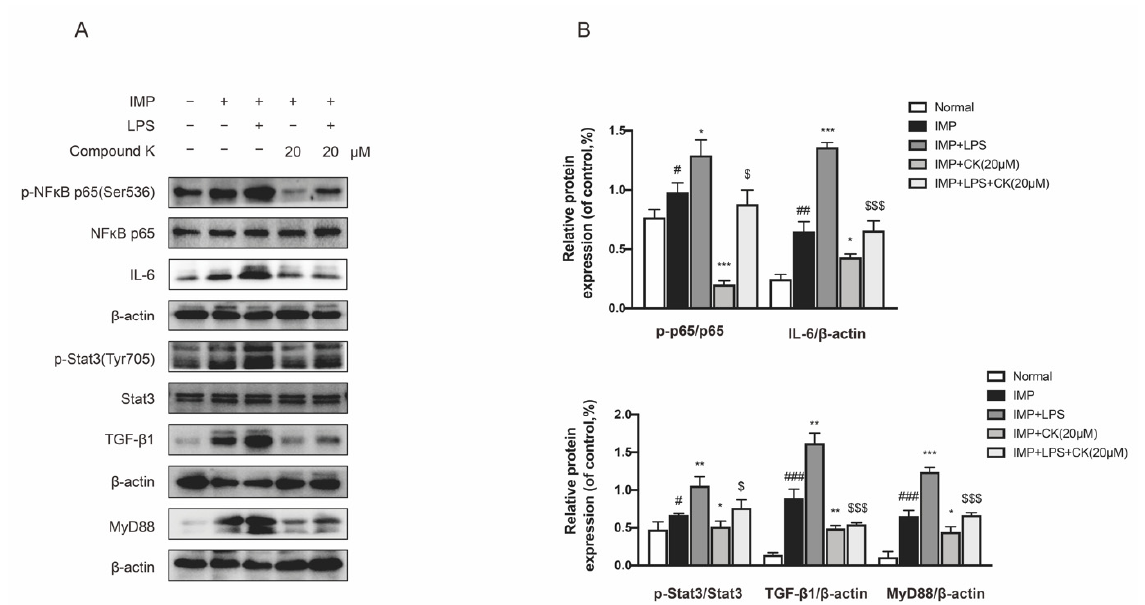
Figure 6. CK attenuates DKD renal injury through inhibiting IMP-induced inflammation and fibrosis. ( A ) The levels of TLR4 pathway related proteins were detected by CK treatment under IMP pretreatment with or without LPS. ( B ) Data in ( A ) were expressed as means ± SEM ( n = 3). ### p < 0.001, ## p < 0.01, # p < 0.05 compared to normal group. *** p < 0.001, ** p < 0.01, * p < 0.05 compared to IMP group. $$$ p < 0.001, $ p < 0.05 compared to IMP + LPS